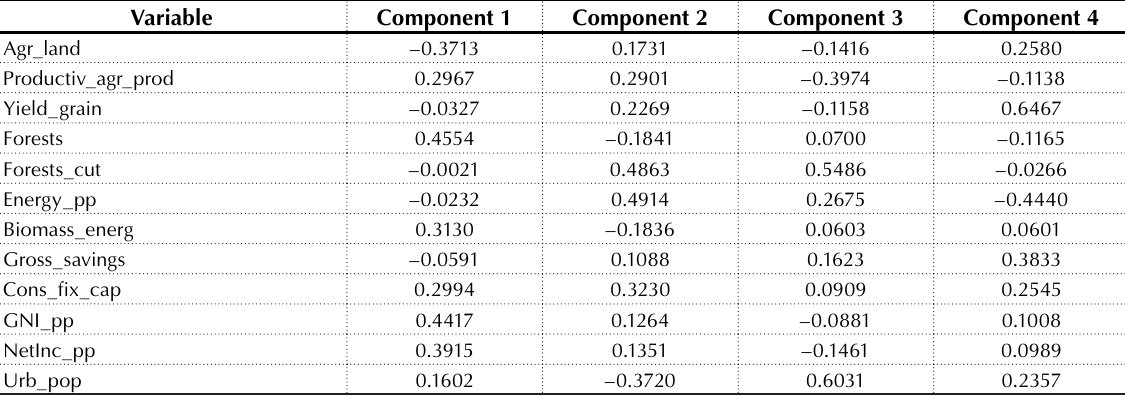
Table 3. Distribution of variables in selected components